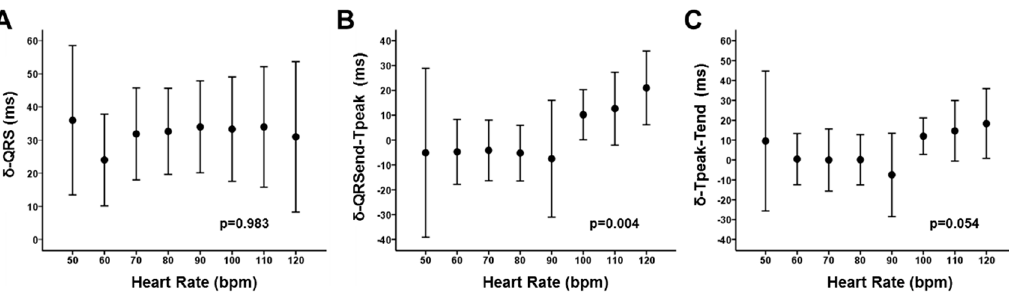
Figure 4. Heart rate dependence of δ -QRS, δ -QRSend-Tpeak and δ -Tpeak-Tend. See text for discussion.